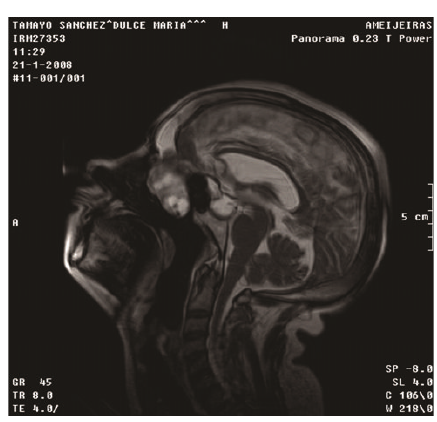
Figure 2: MRI, sagital view.